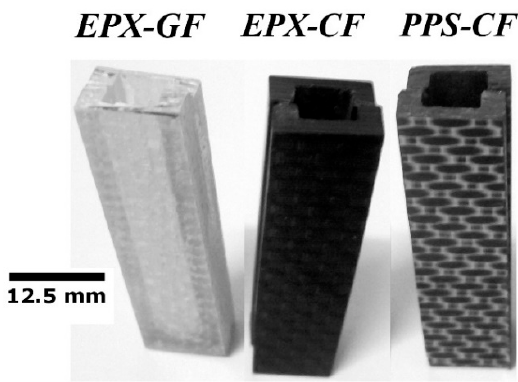
Figure 3. Mini vessels utilized for the detection of MRI artefacts in fibre-reinforced polymer (FRP) laminates. From left to right: EPX-GF, EPX-CF, and PPS-CF